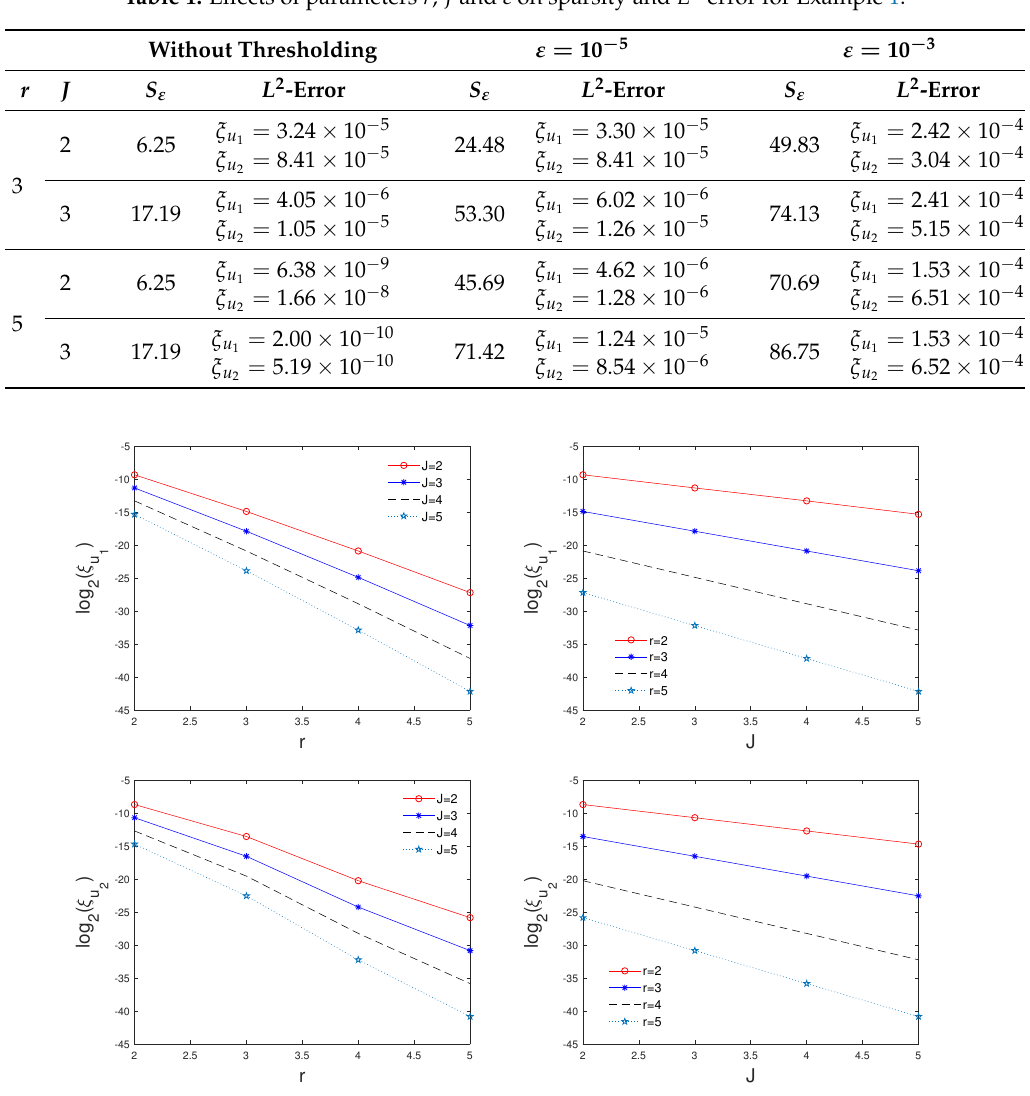
Table 1. Effects of parameters r , J and ε on sparsity and L 2 -error for Example 1.